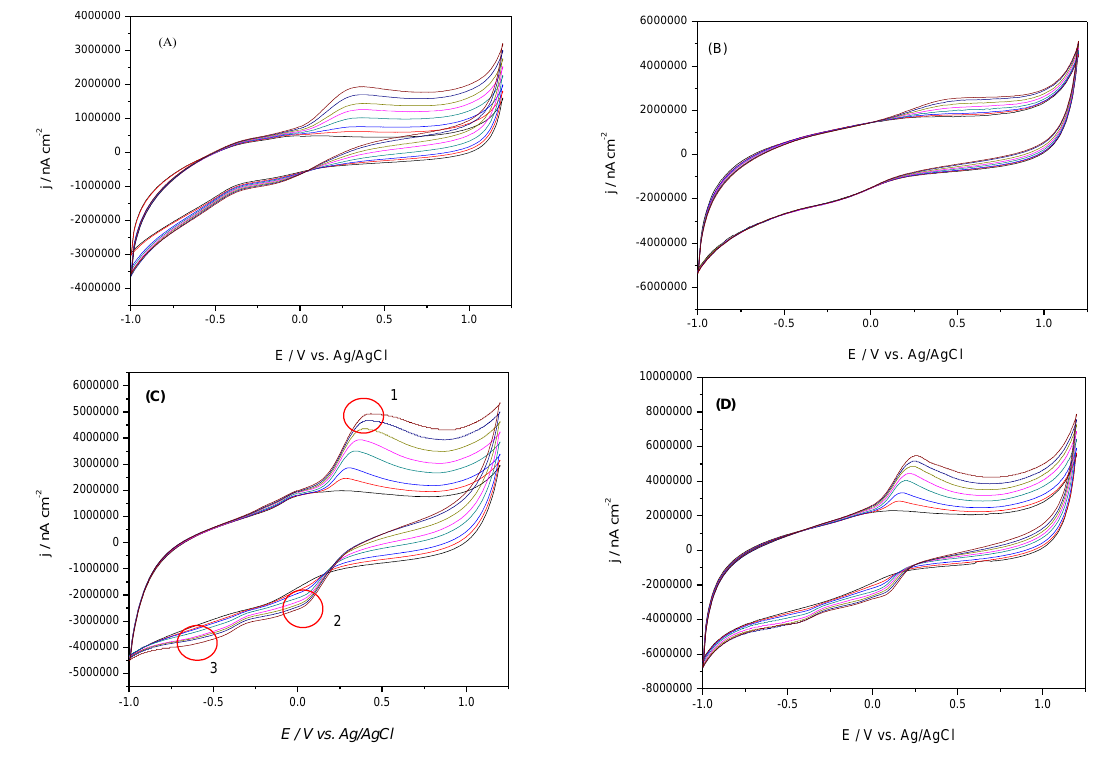
Figure 3. Cyclic voltammograms recorded at ( A ) µ-GEC; and ( B ) µ-SZ-GEC in 50 mM PBS supporting electrolyte with increasing concentrations of AA: 125 μM, 250 μM, 500 μM, 750 μM, 1 mM, 1.25 mM, 1.5 mM; Cyclic voltammograms recorded at; ( C ) µ-GEC and ( D ) µ-SZ-GEC in 50 mM PBS supporting electrolyte with increasing concentrations of DA: 125 μM, 250 μM, 500 μM, 750 μM, 1 mM, 1.25 mM, 1.5 mM; Pt reference electrode and Ag/AgCl auxiliary electrode; potential range from −1.0 V to +1.2 V; scan rate 250 mV·s −1 ;